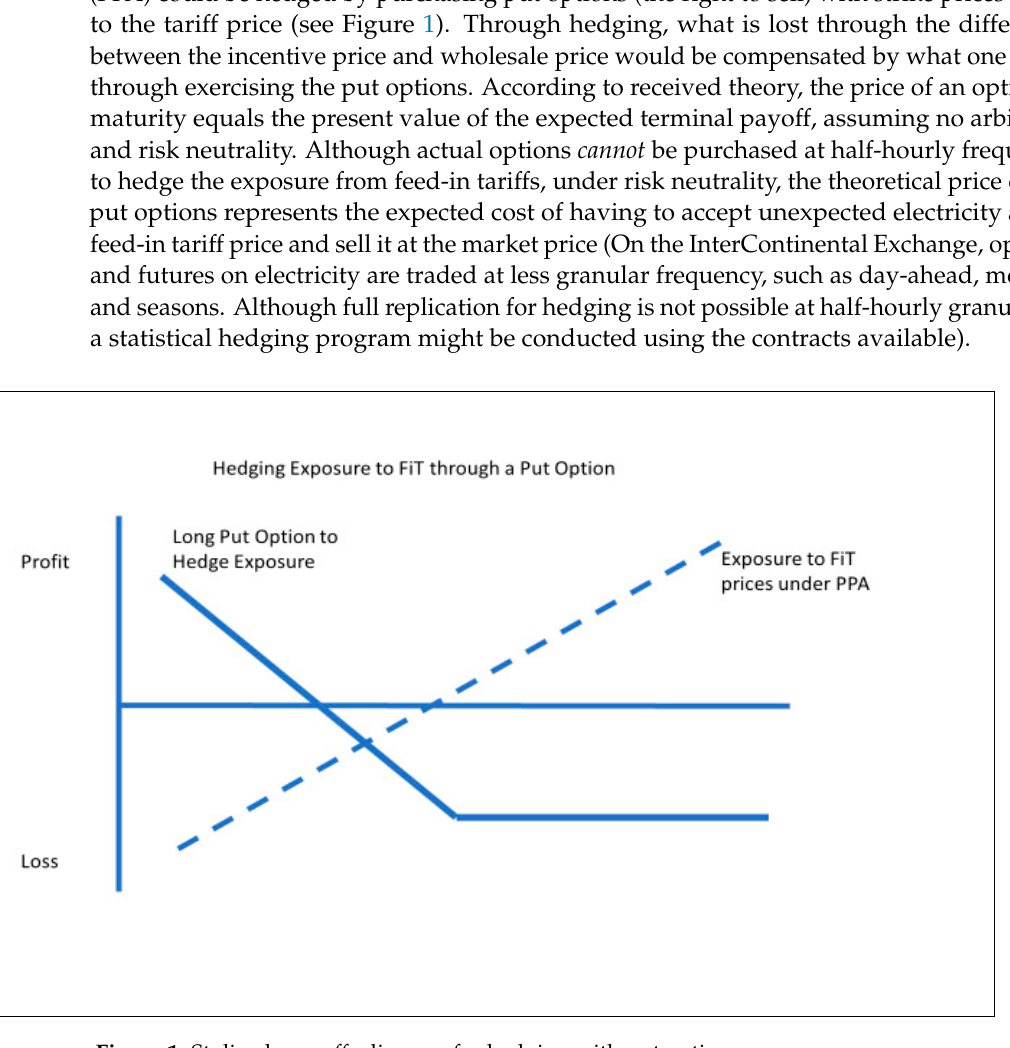
use the well-known Black and Scholes (BS) analytic formula for pricing a European style put options with strike prices equal to the feed-in tariff (A “European” style option can only be exercised at expiration, unlike an “American” style option, which may be used anytime during the life of a contract [91]. Although more complex option theory models have been developed allowing the relaxation of such assumptions as prices following ge- ometric Brownian motion [69], use of the Black–Scholes option theory to price risk in elec- tricity markets is accepted practice in the utility and financial sector [92,93]. As having insurance compensates for a loss, owning put options conferring the right to sell electricity at the incentive price would neutralize the cost of accepting RE under the FiT Scheme. In financial theory, options are priced according to the five parameters shown in Table 1 (The differential equation for pricing of options appears in Appendix A). Table 1. Put option parameters (source: adapted by authors from [91]). Parameter